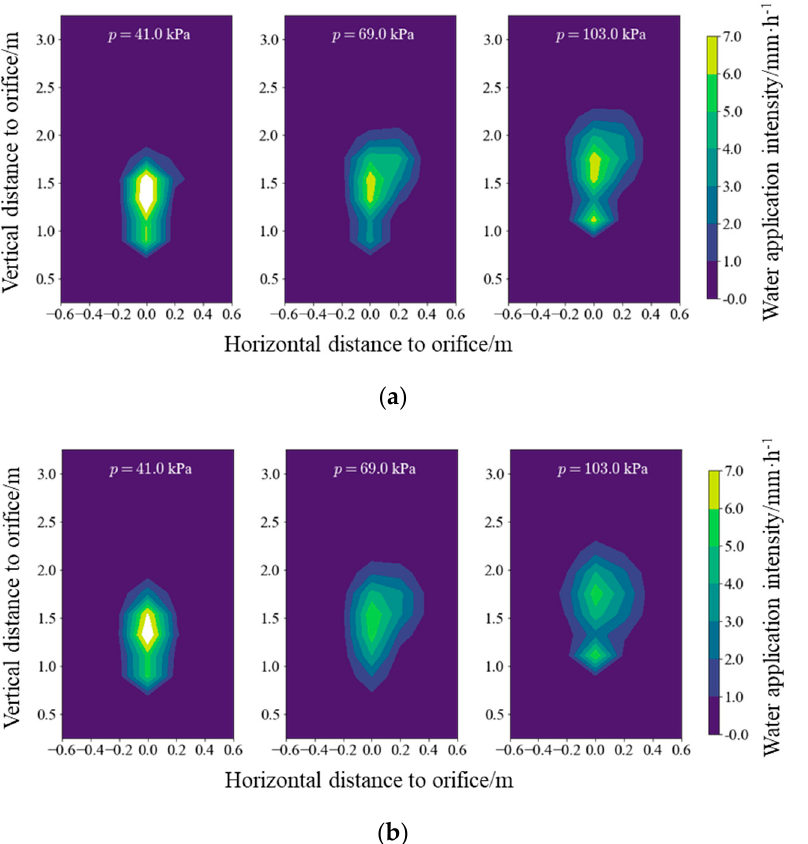
Figure 5. The water application intensity distribution of the individual orifice a 3-4 under different working pressures: ( a ) the measured value; and ( b ) the fitting value.